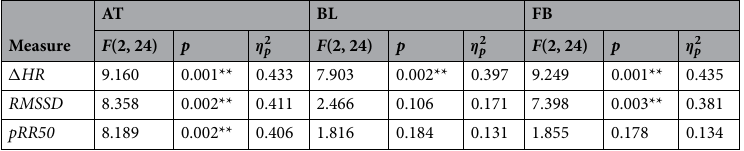
Table 2. HR(V) measures of the Control condition over the course of the MIST phases. Repeated- measurement ANOVAs were performed separately for BL, AT, and FB subphases with MIST phase as within- variable.